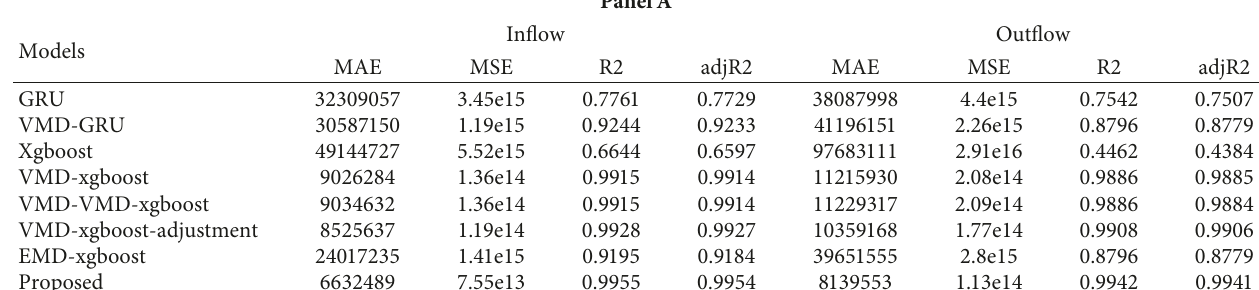
Table 2: Single-step forecasting (one hour ahead) results and error comparison among different forecasting models.